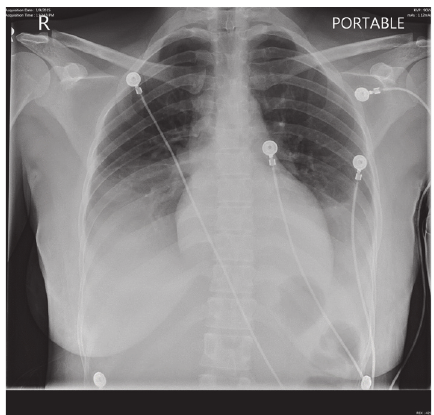
Figure 3: Repeated chest X-ray.